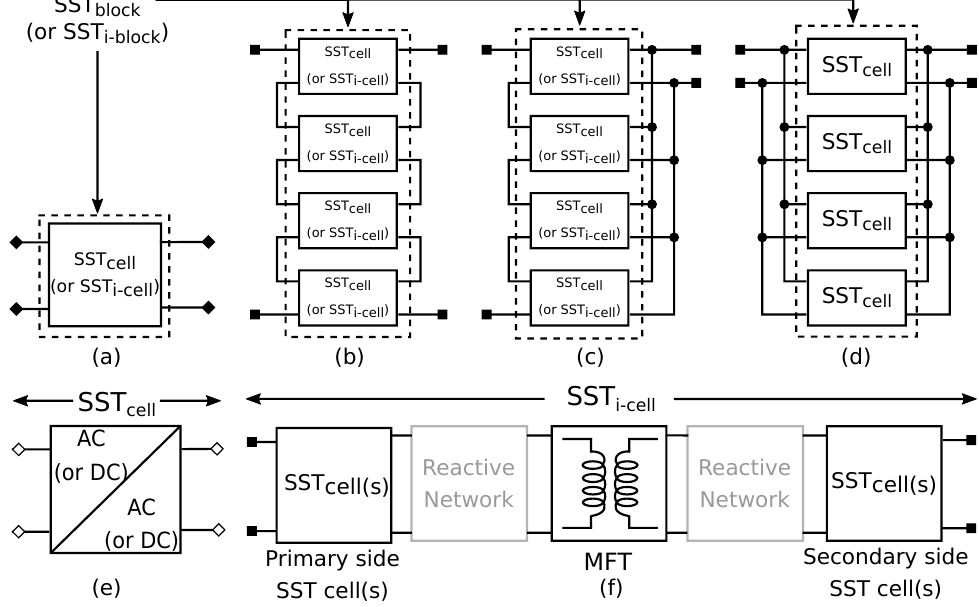
Figure 7. Converter level integration [48–50]: ( a ) single SST cell , ( b ) multiple SST cell with ISOS interconnection, ( c ) multiple SST cell with ISOP interconnection, ( d ) multiple SST cell with IPOP interconnection, ( e ) topological equivalent of SST cell and ( f ) topological equivalent of SST i-cell